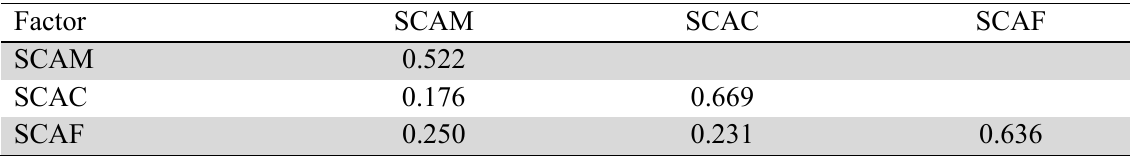
Discriminant validity analysis of SCA